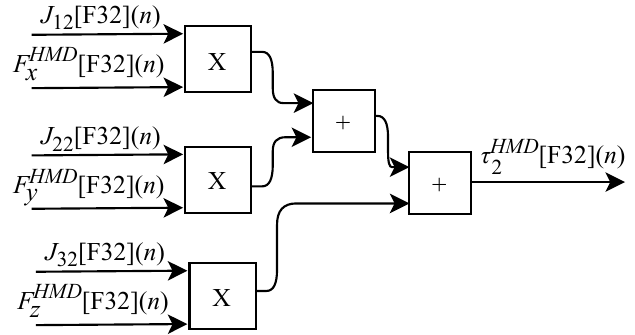
[ F 32 ]( n ) joint (Equation (40))—KFF. 2